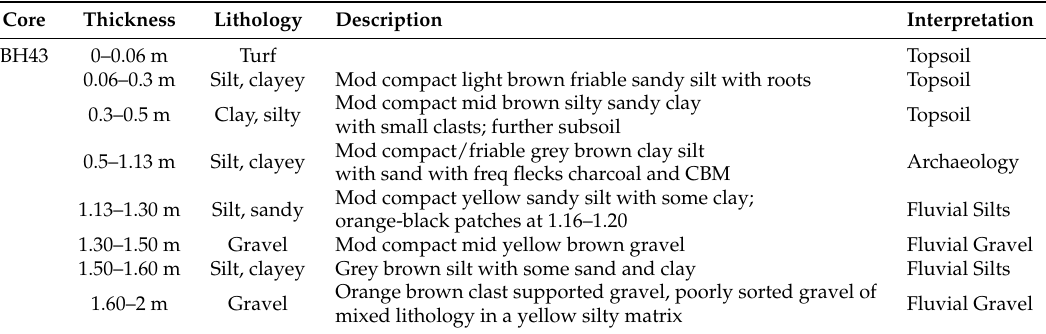
Table 3. Description of core BH43. Mod: Moderate ; Freq.: Frequent ; CBM: Common Building Material